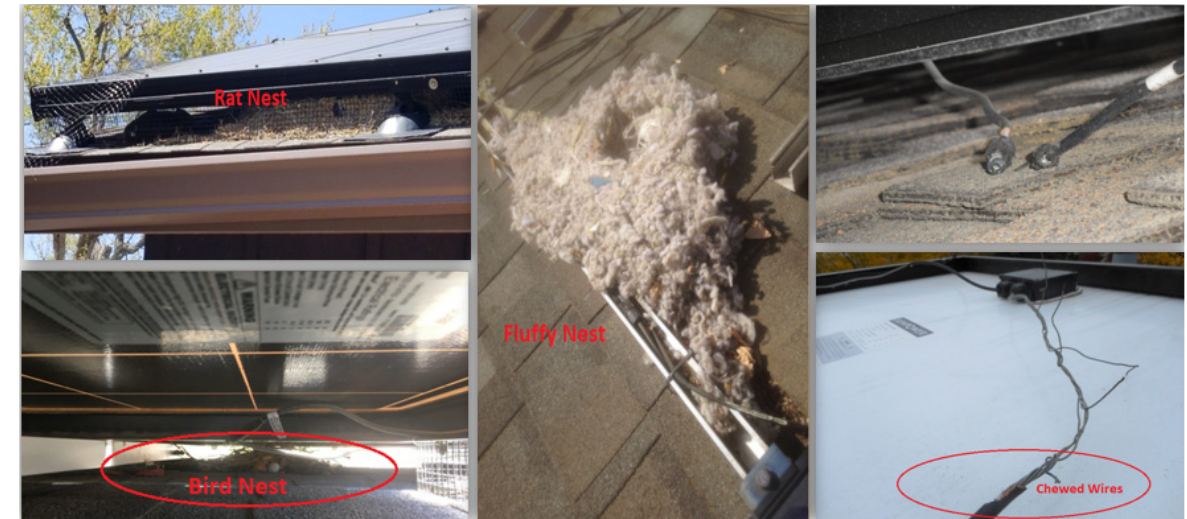
Figure 3. Pest damage to solar PV arrays [25].